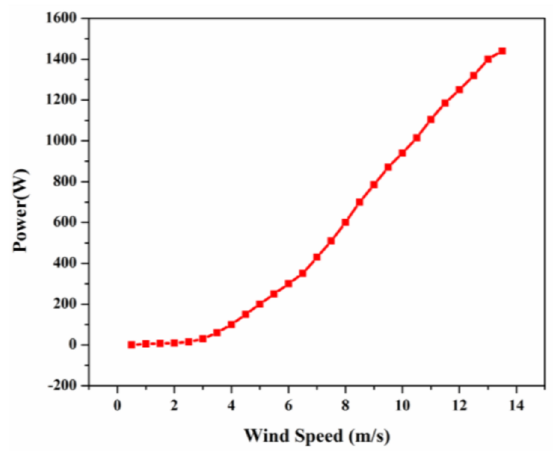
Figure 6. Power curve of wind turbine used for analysis.